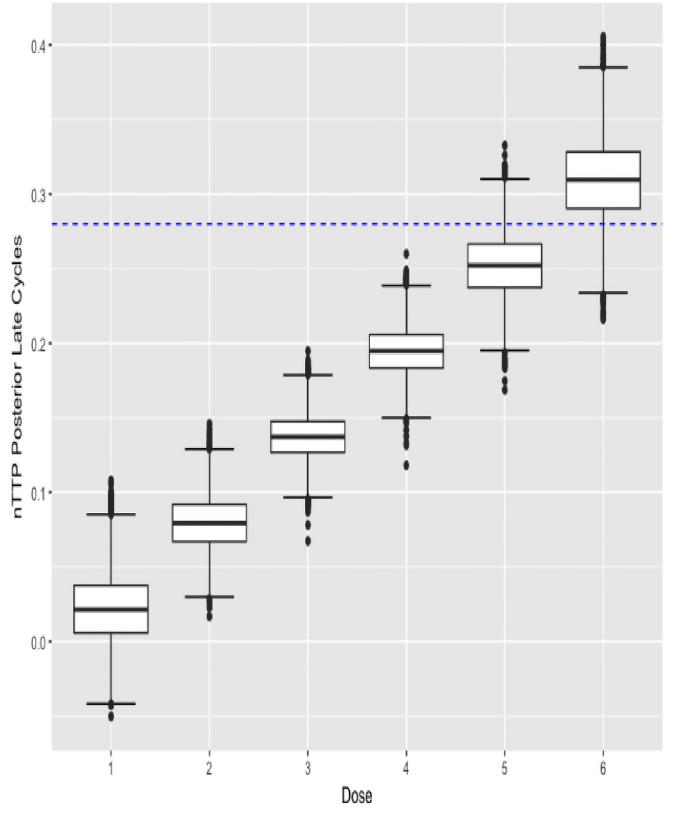
Fig 4. Late cycle posterior